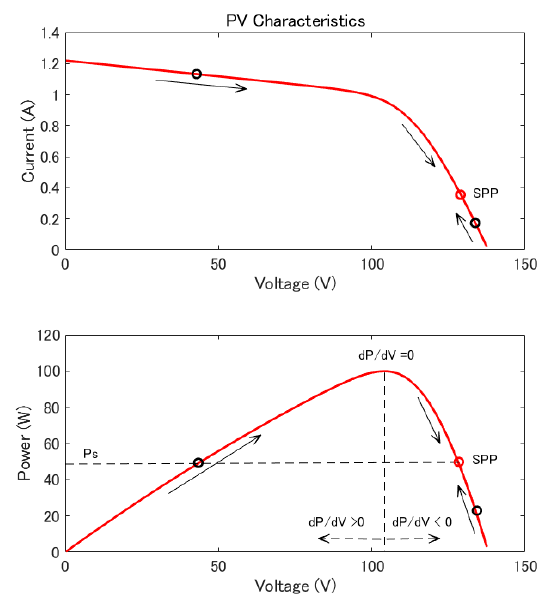
8 of 17 Figure 6. Characteristic PV and MPPT control curves.